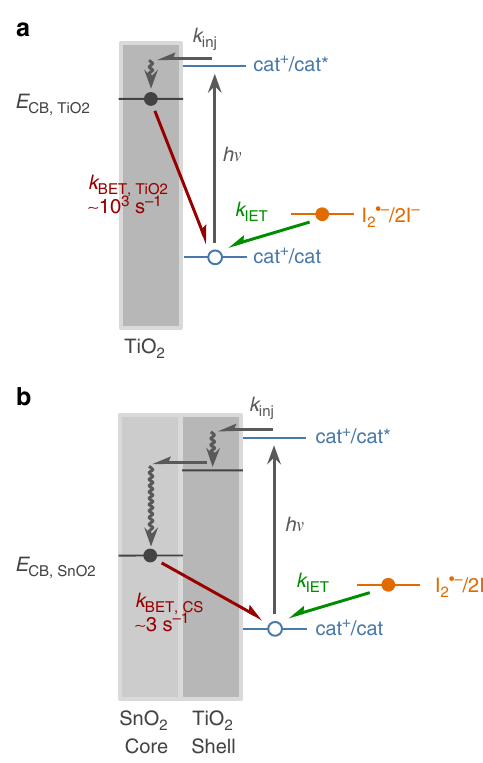
Fig. 3 Electron transfer reactions at photoredox functionalized metal oxide interfaces. A schematic depicting the major electron transfer reactions that occur at functionalized TiO 2 ( a ) or SnO 2 -TiO 2 core-shell ( b ) interfaces: excitation of the catalyst by a photon ( h ν ), electron injection into the semiconductor ( k inj ), back-electron transfer ( k BET ), and intermolecular electron transfer ( k IET ). The energy levels of the catalyst redox potentials in the ground and excited states (cat + /cat and cat + /cat*, respectively), the diiodide redox potential (I 2 (cid:129)– /2I – ), and the conduction bands of TiO 2 and SnO 2 ( E CB, TiO2 and E CB, SnO2 , respectively) are depicted on an approximate relative energy scale